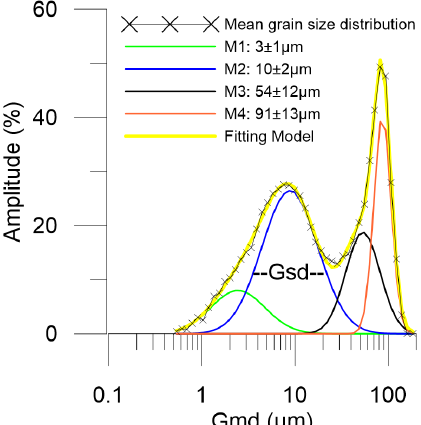
Figure 2. Comparison between a measured grain size distribution and the fitted curve using lognormal function and its partitioning into four individual grain size modes. The measured data are a mean grain size distribution from all samples of B6 and G10